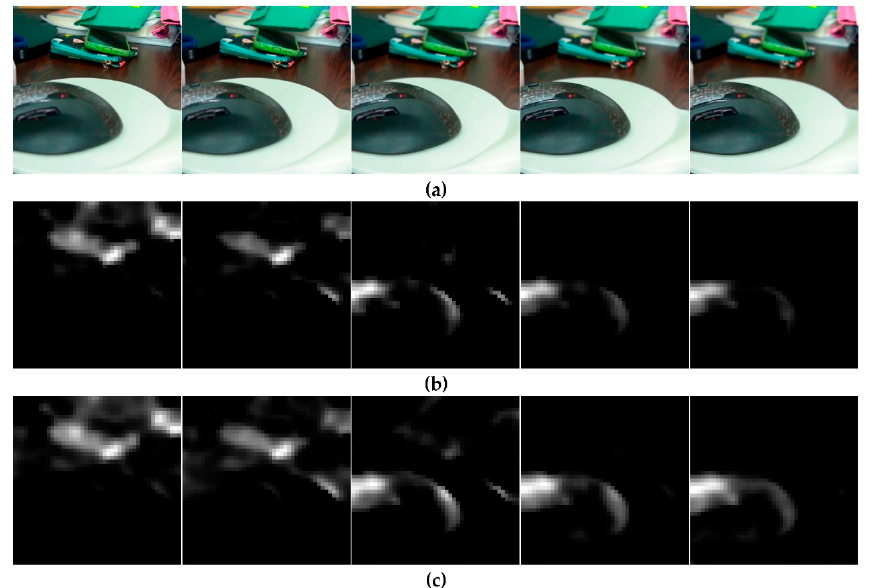
Figure 10. In-focused regions of the di ff erent focal stack images using SML and SUML: ‘Mouse’ dataset; ( a ) The di ff erent focal stack images of ‘Mouse’ dataset; ( b ) SML of stack images; and ( c ) SUML of stack